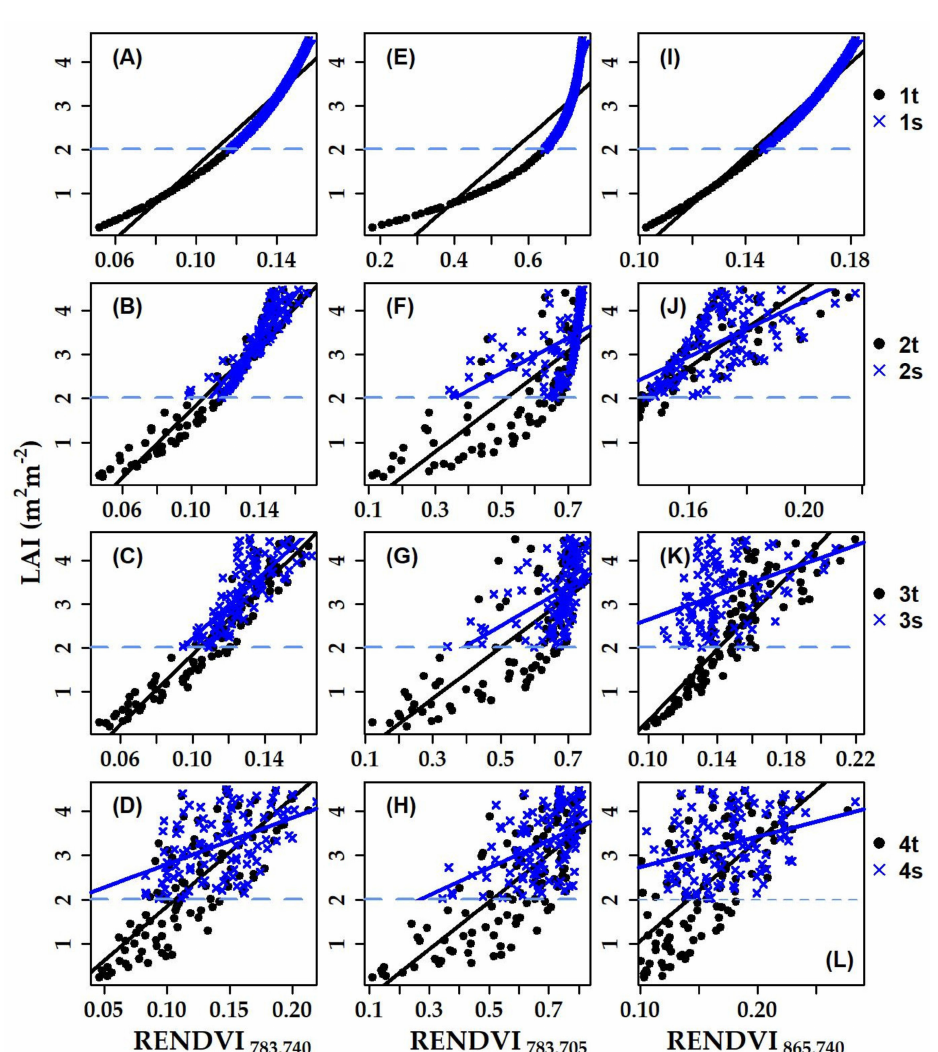
Figure 11. Relationships between RE indices and LAI for all eight scenarios for both temporal (( A , E , I ) 1t; ( B , F , J ) 2t; ( C , G , K ) 3t; and ( D , H , L ) 4t) and spatial scale observations (( A , E , I ) 1s; ( B , F , J ) 2s; ( C , G , K ) 3s; and ( D , H , L ) 4s). The horizontal dashed line represents the minimum value of LAI when PROSAIL was run using spatial observation LAI ranges as input parameter. In all panels, solid lines represent a linear fit to the